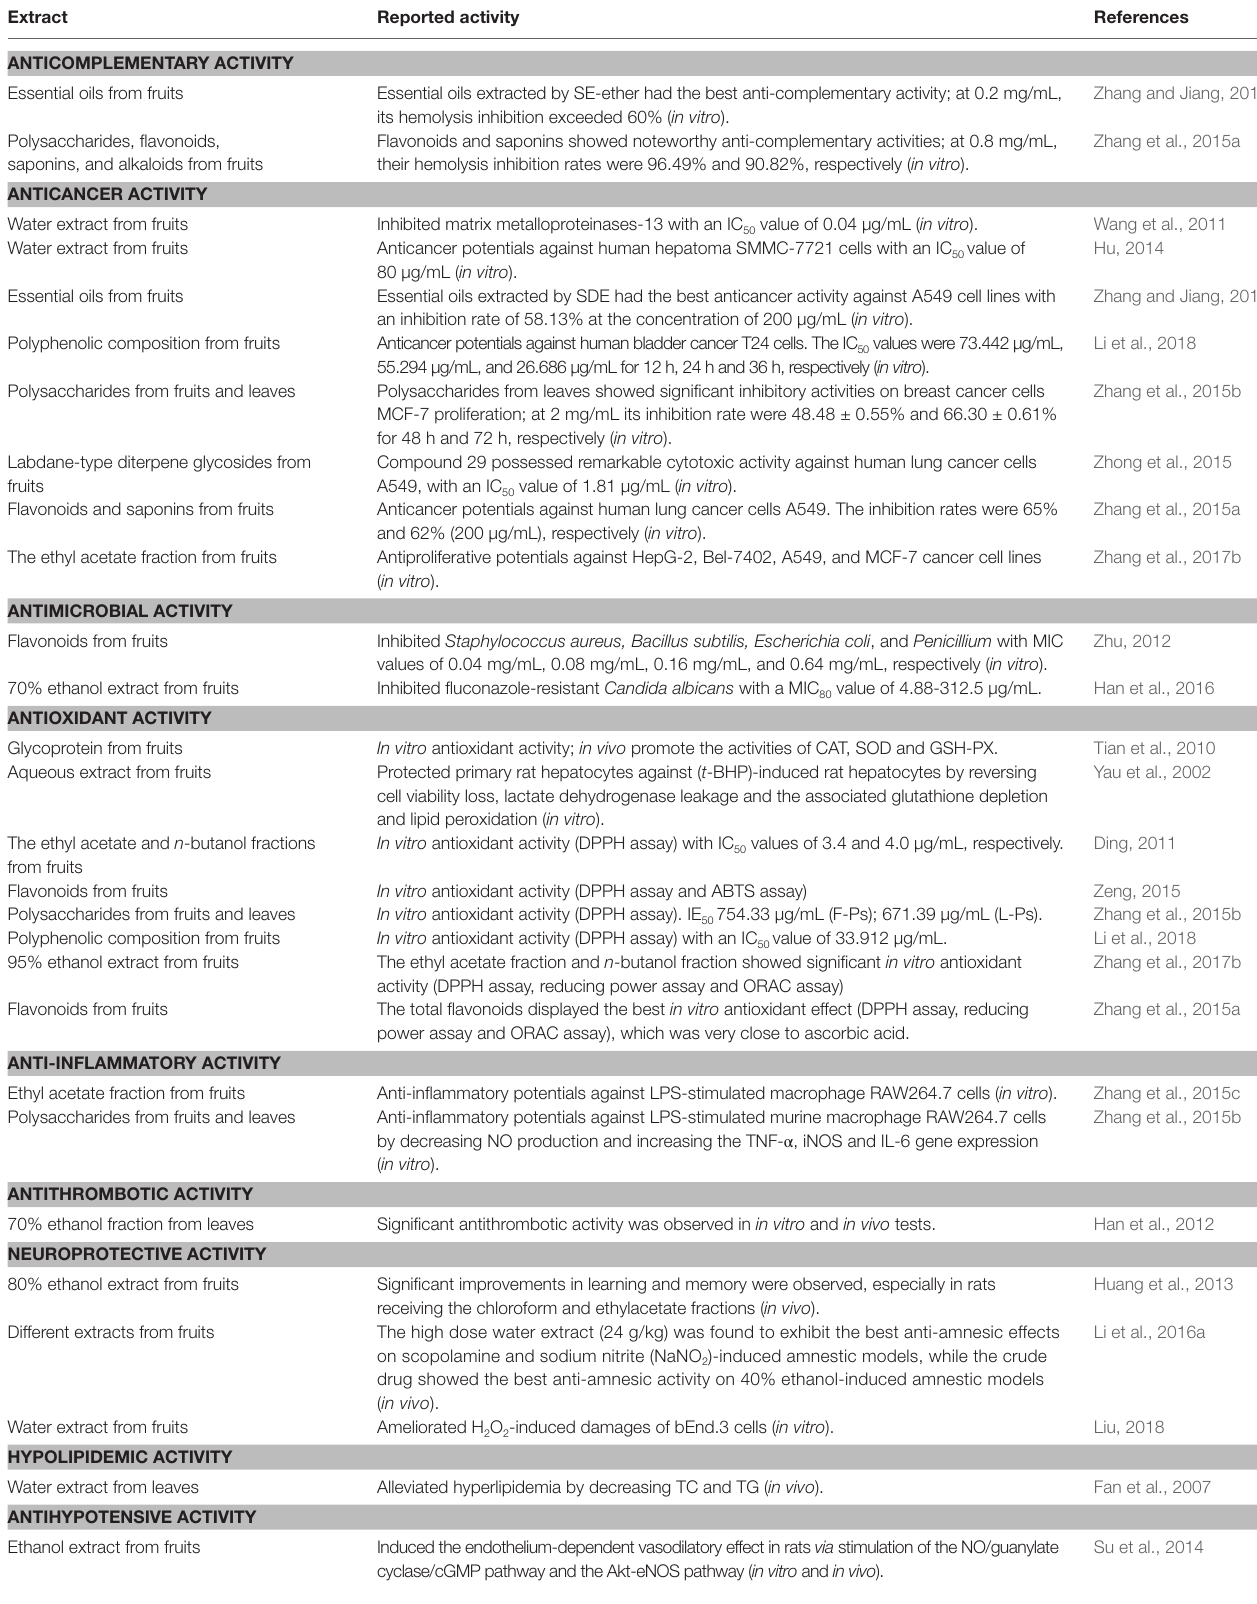
TABLE 2 | Reported biological activities in vitro and in vivo of R. chingii crude extracts and